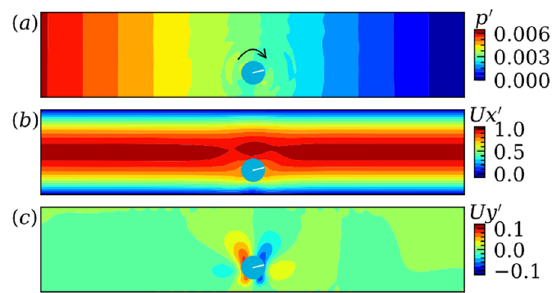
Figure 6. The contour view of (cid:4666)𝐚(cid:4667) the dimensionless pressure 𝑝 (cid:4593) , (cid:4666)𝐛(cid:4667) the dimensionless fluid ve- locity in 𝑋 direction 𝑈 (cid:3051)(cid:4593) and (cid:4666)𝐜(cid:4667) in 𝑌 direction 𝑈 (cid:3052)(cid:4593) in stable state of particle migrating in non-pul- satile flow at 𝑘 (cid:3404) 0.25 and 𝑅𝑒 (cid:3404) 50 .